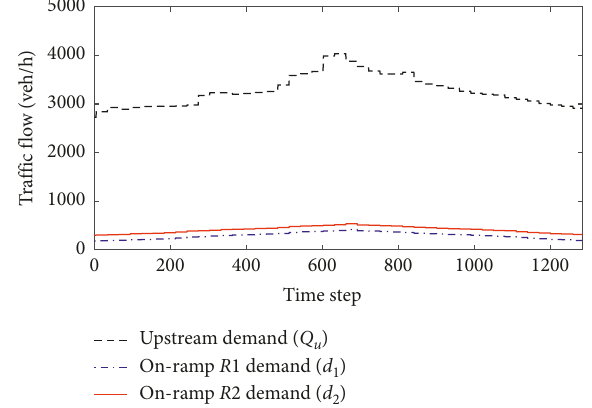
Figure 8: Traffic demand of upstream, on-ramp R 1, and on-ramp R